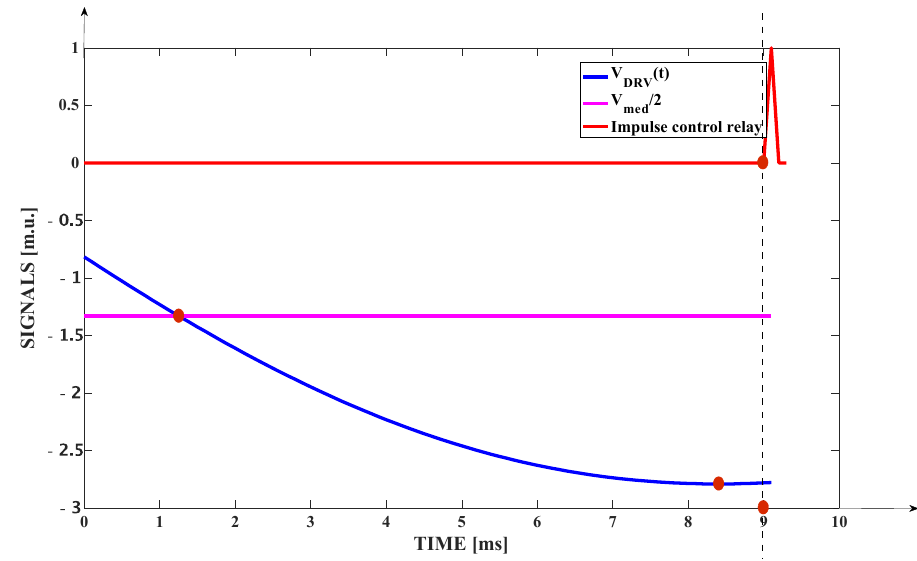
Figure 21. Highlighting the detection of the fault through the dynamics of the V DRV (t) signal.